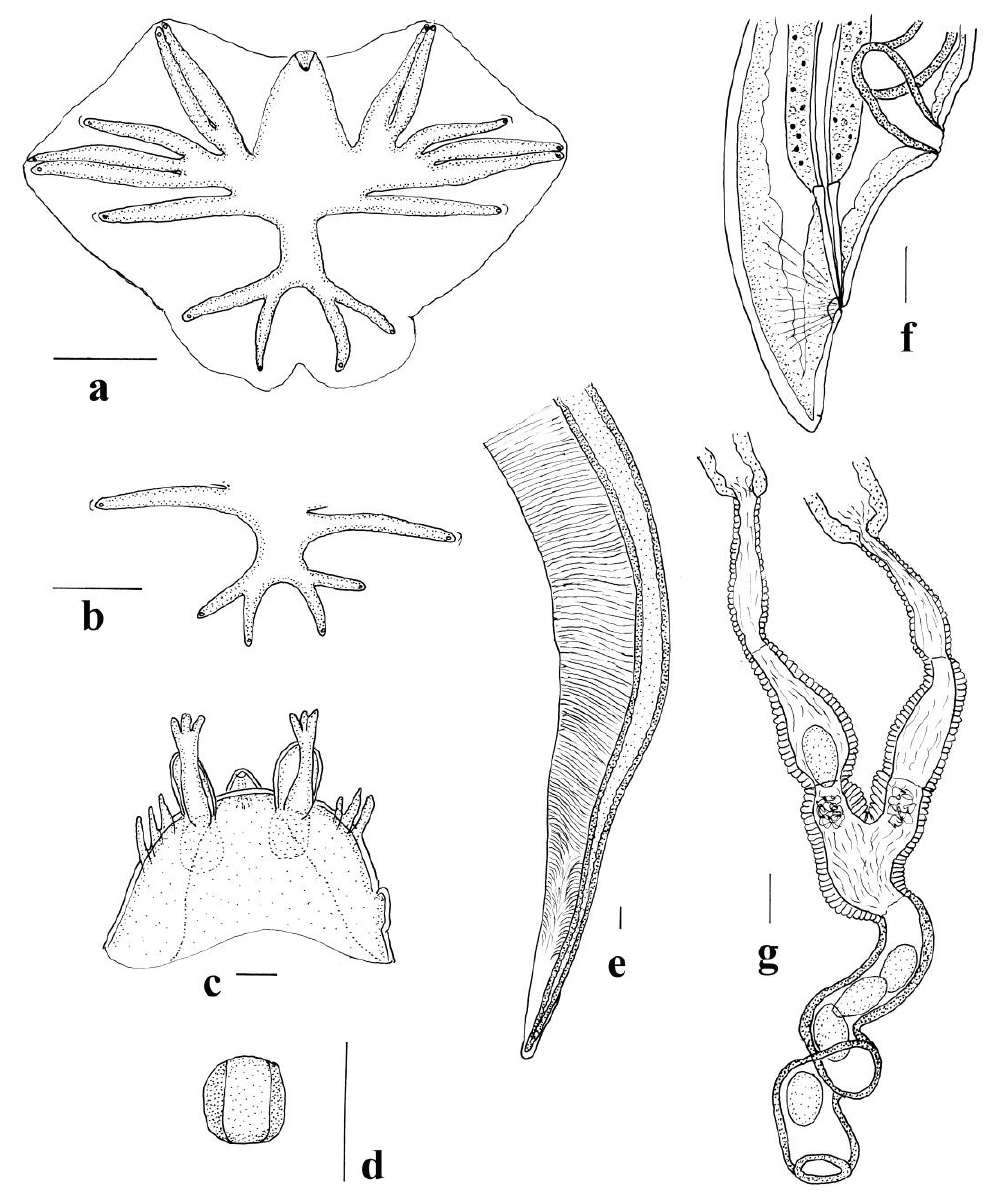
Figure 2. Torquenema toraliforme n. comb. (a) Bursa, apical view; (b) Dorsal ray of bursa, dorsal view; (c) Genital cone, dorsal view; (d) Gubernaculum; (e) Spicule tip, lateral view; (f) Female tail, lateral view; (g) Vagina and ovejector, lateral view. Scale-bars: (a, b, f – g), 0.1 mm; (c-e), 0.01 mm.